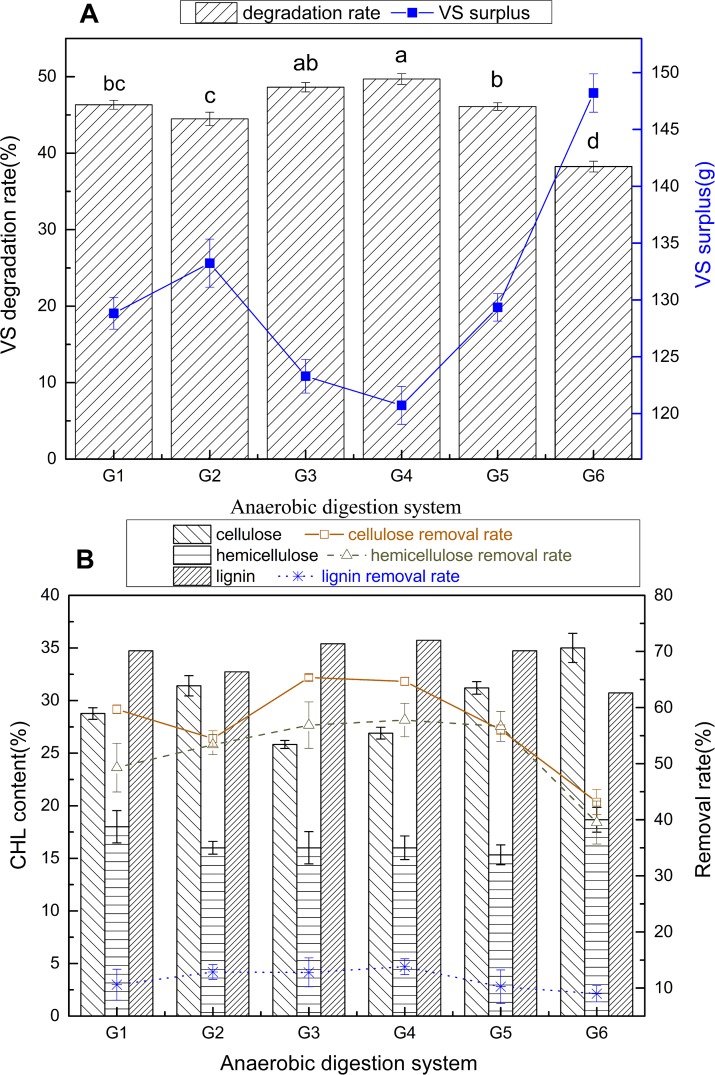
Biodegradation of ORS after two phase anaerobic digestion process: A. VS degradation rate and surplus, B. cellulose, hemicellulose and lignin content in fermented oilseed rape straw. CHL: cellulose, hemicellulose and lignin. The mean values were calculated from three repeats, and standard deviations were represented by vertical bars. Different letters mean significant difference with a probability p < 0.05.